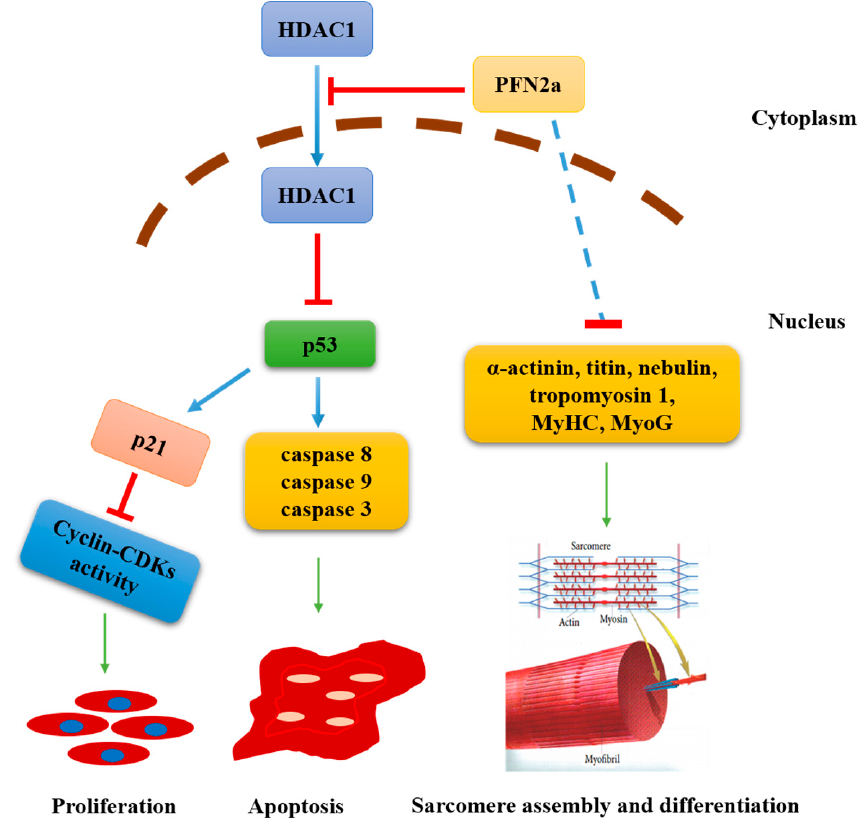
Figure 7. PFN2a overexpression downregulates myogenic development via the p53 pathway in C2C12 cells. We constructed a C2C12 PFN2a -overexpressing cell line through the CRISPR / Cas9 system. During C2C12 myogenic development, PFN2a decreased the content of HDAC1 in the nucleus and upregulated p53 expression. PFN2a downregulated C2C12 proliferation and promoted apoptosis through p53 by directly reducing the content of HDAC1 in the nucleus. PFN2a destructed the sarcomere structure assembly by indirect downregulation on the mRNA levels of α -actinin , titin , nebulin , and tropomyosin 1 . Inhibition of proliferation and promotion of apoptosis led to di ff erentiation inhibition and sarcomere structure assembly